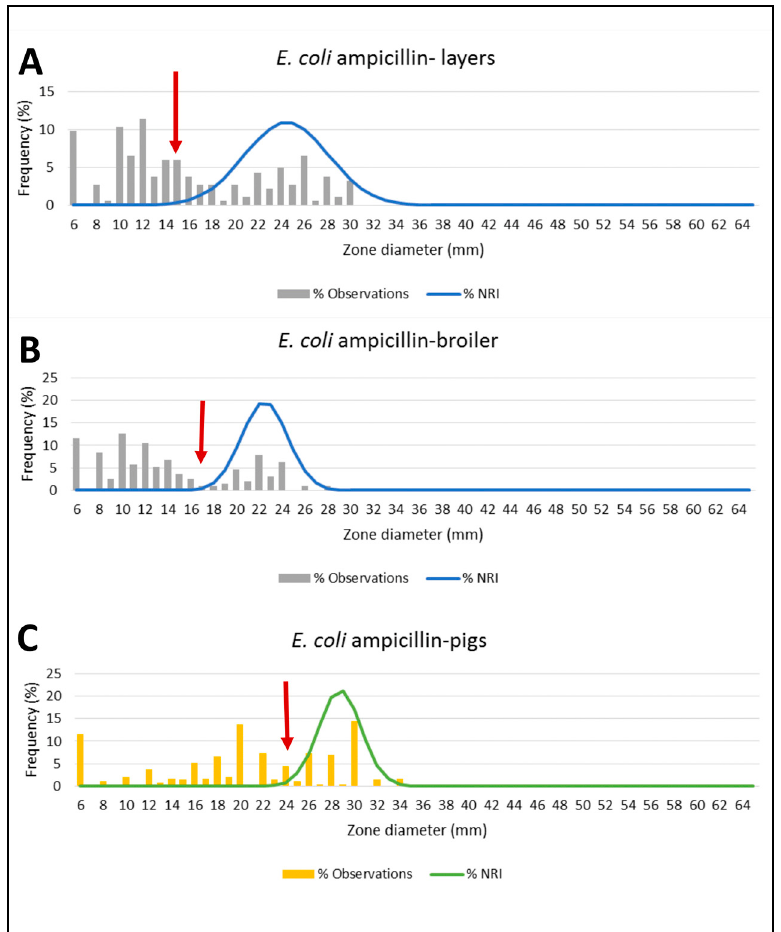
Figure 2. The ECVs of AMP tested against E. coli isolated from layers, broilers, and pigs. The arrow indicates where the ECV is located in a histogram, and distribution of WT and non-WT E. coli as determined by NRI. Subfigure ( A ) shows ECV of AMP tested against E. coli from layers which is 15 mm; subfigure ( B ) shows ECV of AMP tested against E. coli from broilers which is 17 mm; and subfigure ( C ) shows ECV of AMP tested against E. coli from pigs which is 24 mm. There is a varying proportion of wild type (WT) distribution when a human clinical breakpoint is used compared to when ECVs are used. Notably, clinical breakpoints